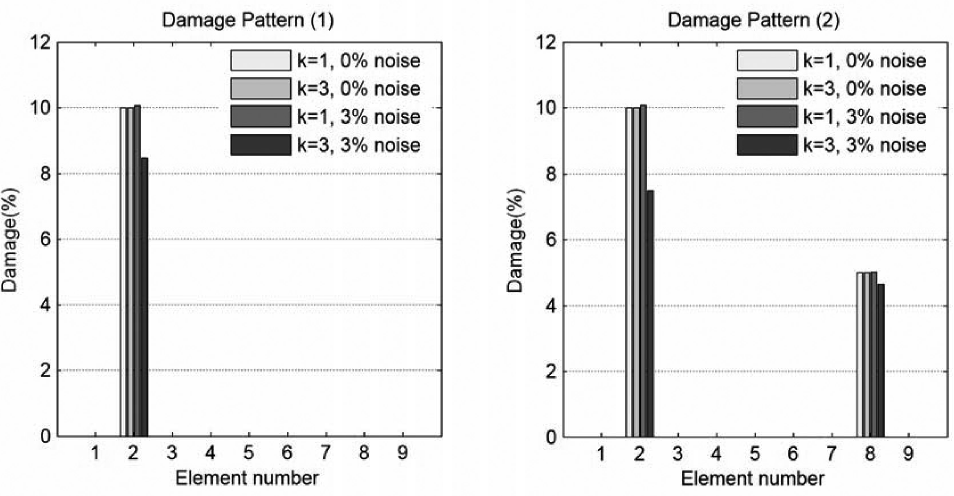
Fig. 7. Results of damage identi fi cation for two damage patterns of the three-story plane steel frame.